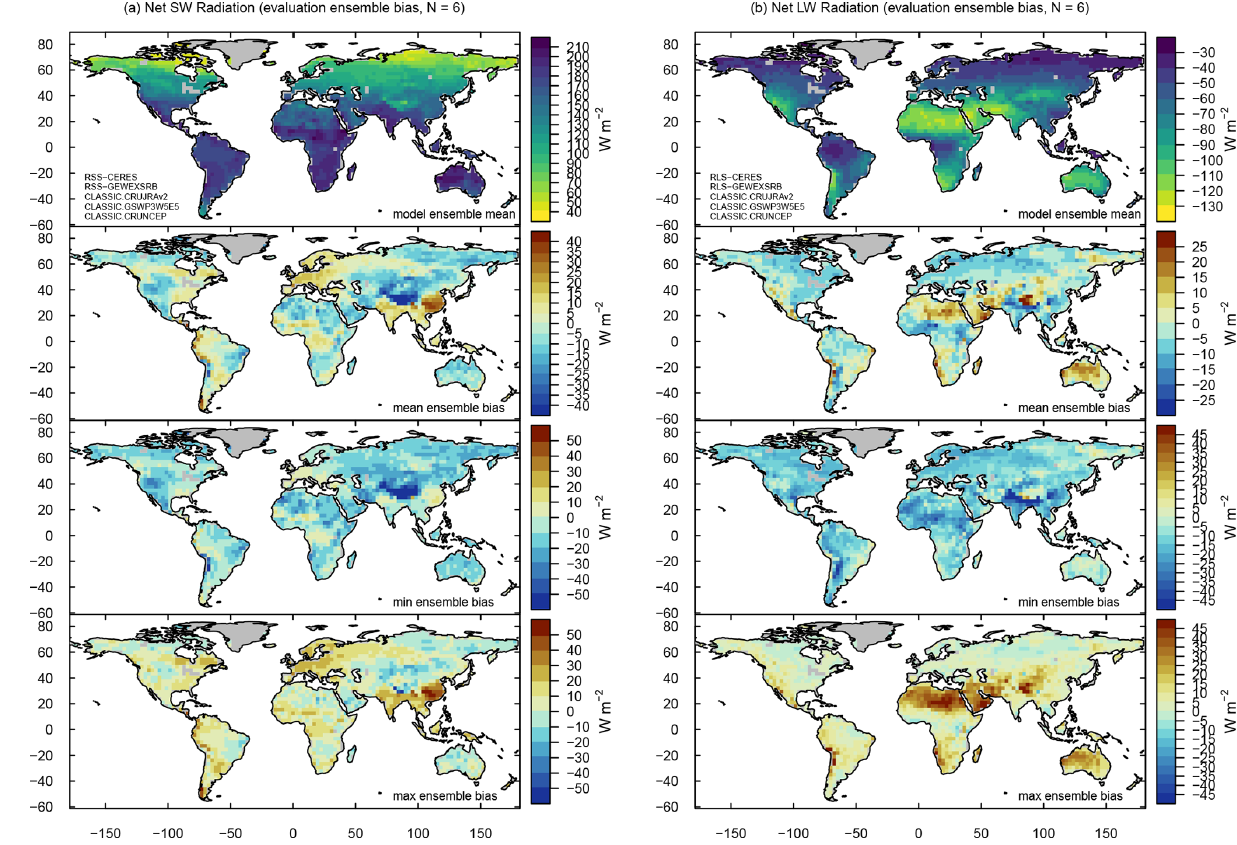
Figure A3. Same as Fig. 7 but for (a) net SW radiation and (b) net LW radiation.